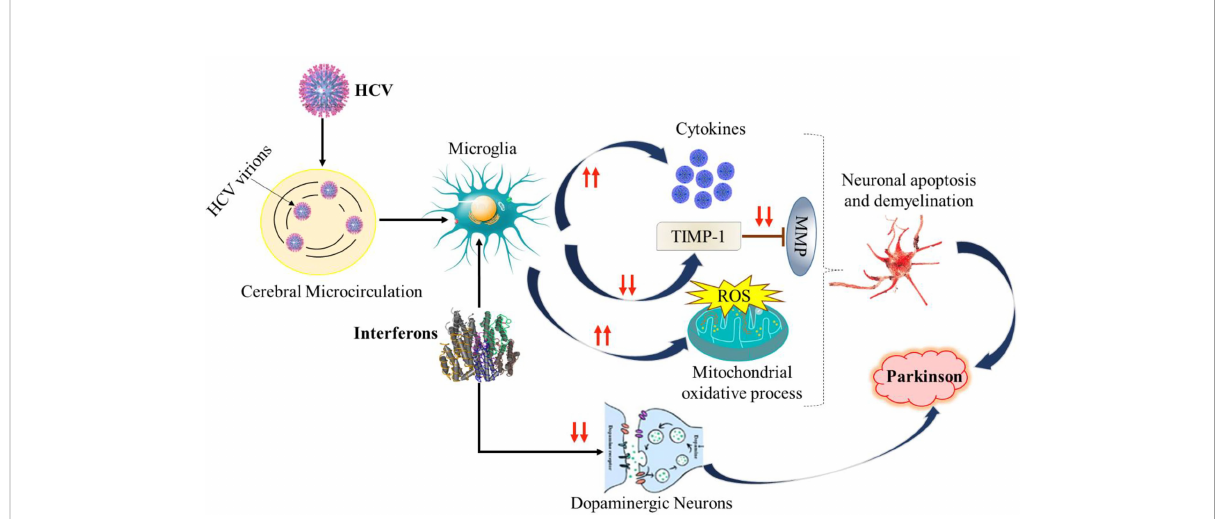
FIGURE 3 Depiction of Possible mechanisms of HCV-PD. TIMP-1, Tissue inhibitor of metalloprotease-1; MMP, Matrix metalloproteinase. ROS, Reactive oxygen